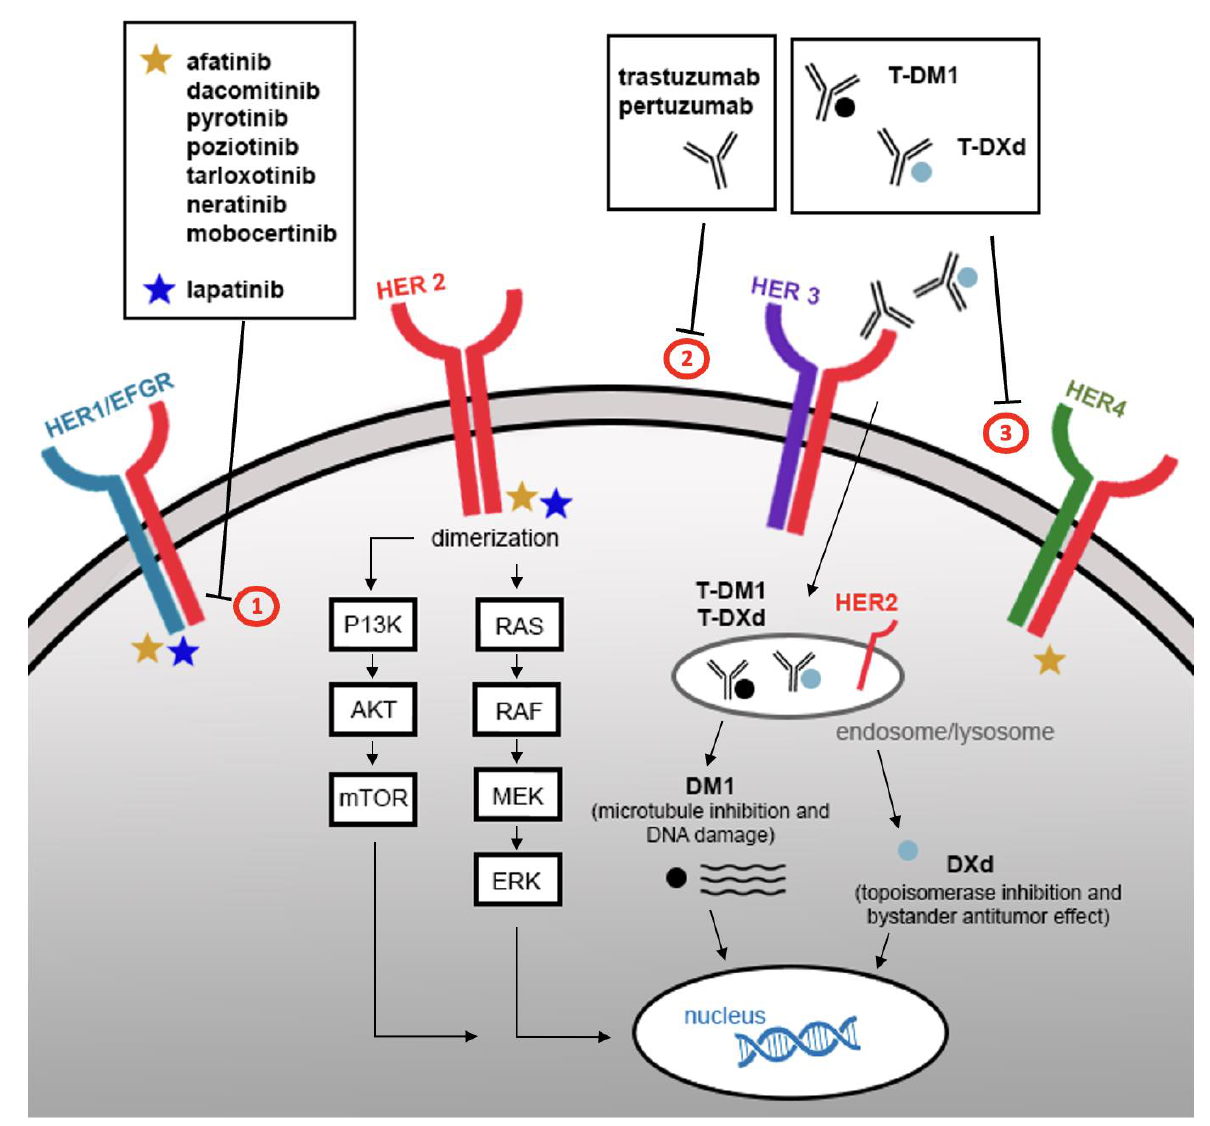
Figure 1. Non – small cell lung cancer HER2 tumorigenesis pathways and targeted therapy mechanisms. The HER2 extracellular domain does not have a known soluble ligand and is activated by forming homo or heterodimers, which leads to phosphorylation and activation of downstream PI3K/AKT and MEK/ERK pathways. (1) Tyrosine kinase inhibitors block phosphorylation of the tyrosine kinase residues, inhibiting cell proliferation. (2) Monoclonal antibodies bind to the extracellular domain of HER2 to block homo and heterodimerization. (3) Antibody – drug conjugates (ADC) incorporate the HER2 targeted actions of trastuzumab with a cytotoxic component (microtubule inhibitor or topoisomerase I inhibitor) connected by a cleavable tetrapeptide-based linker. Upon degradation of the HER2-ADC complex in endosomes/lysosomes, the cytotoxic component is released. This allows for selective delivery into HER2 overexpressing cells, resulting in cell cycle arrest and apoptosis.